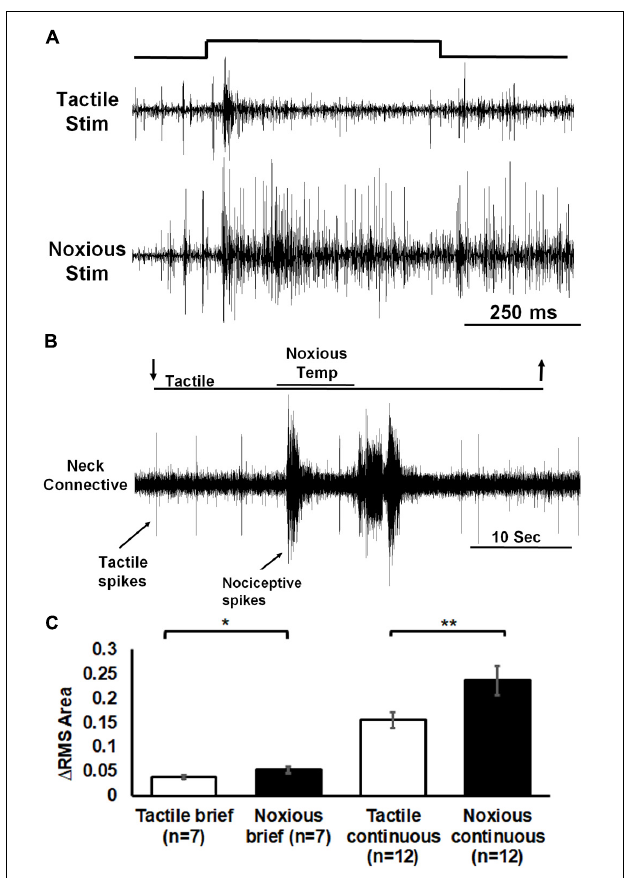
FIGURE 6 | Extracellular recording of neck connective ascending activity following tactile and noxious stimuli shows that noxious information is carried along the nerve cord to the head ganglia. (A) Representative example of neck connective response to brief (0.5 s) tactile (upper trace) or noxious (lower trace) stimuli (stimulus duration is indicated). (B) Activity in the neck connective in response to a continuous transition between tactile and noxious stimuli. Stimulus duration is indicated with horizontal lines and arrows (upper line: noxious; lower line: tactile). (C) The averaged RMS area of the neck connective response to brief (0.5 s)/continuous noxious stimuli is significantly higher than that of brief/continuous tactile stimuli. Bars represent means ± SEM, significance is indicated with asterisk.